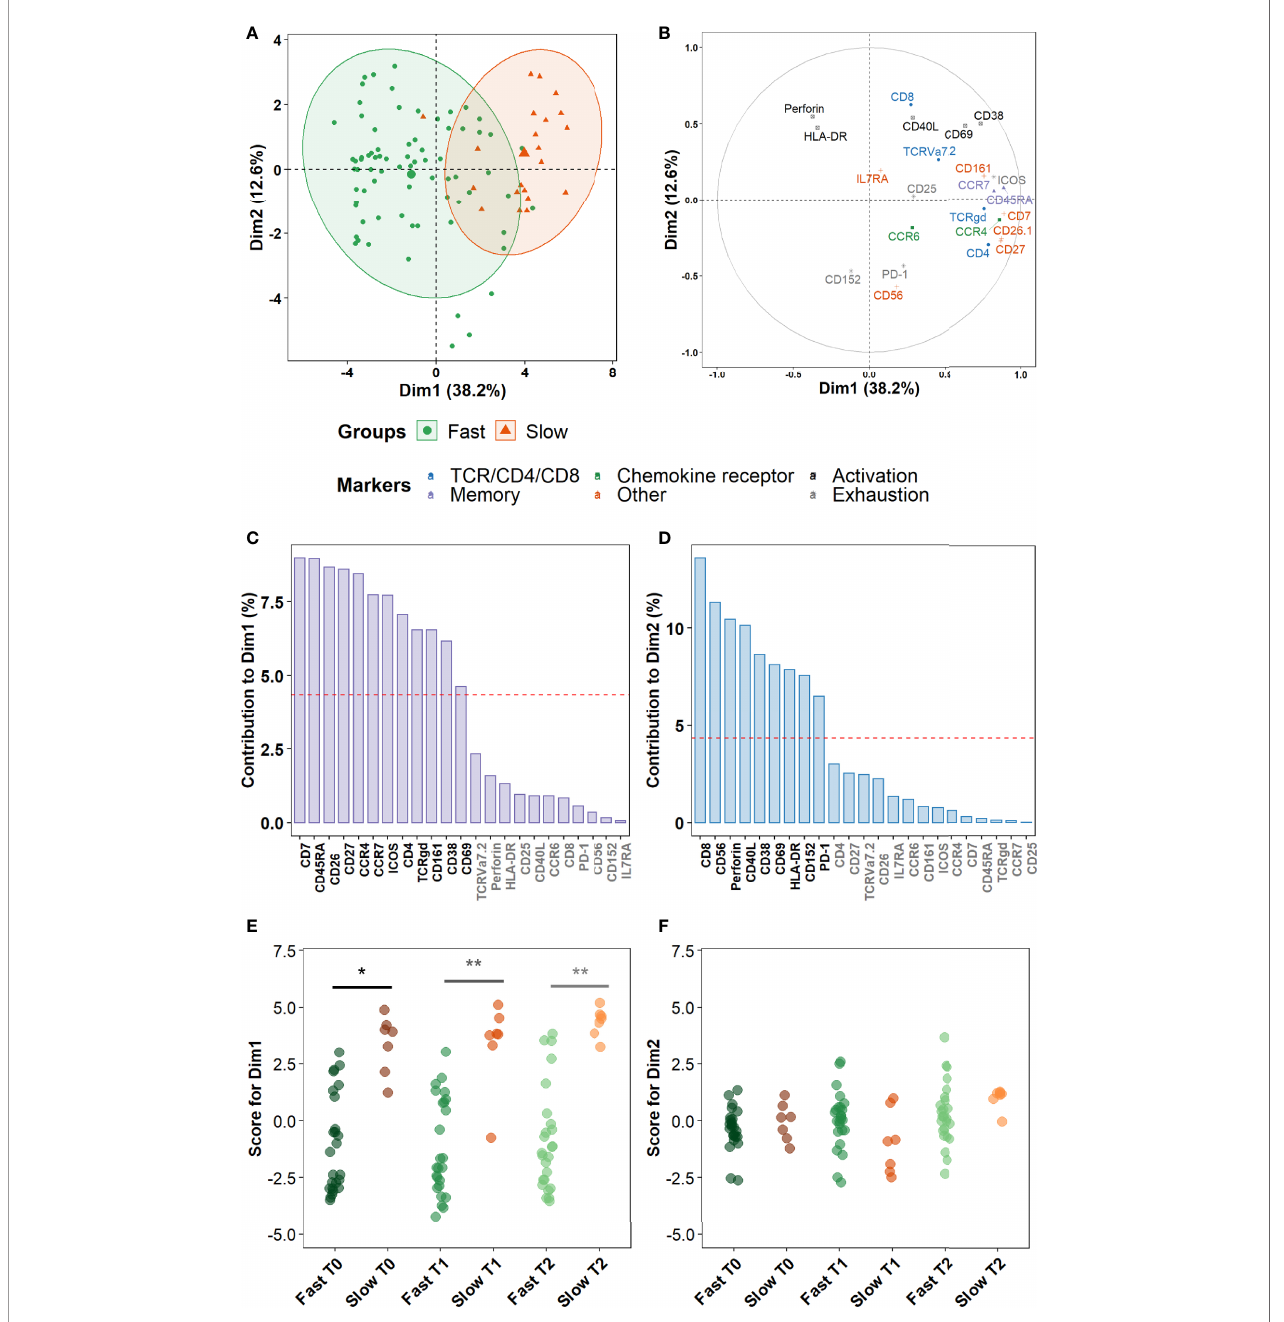
FIGURE 7 | Non-lineage markers discriminate slow and fast responders within differentially abundant subsets. Principal Component Analysis (PCA) was performed on marker expression data from the clusters identi fi ed in Figure 6 , within 96 Mtb -stimulated samples matched at T0, T1, and T2 (TB2: 54 samples; rmsHBHA: 42 samples; see Supplementary Table 1 for sample number details). (A) Explanation of the variance between fast converters (25 samples at each timepoint) and slow converters (7 samples at each timepoint). Axes represent the principal components 1 (Dimension 1, Dim1) and 2 (Dim2). Percentages indicate their contribution to the total observed variance. Axis values represent individual PCA scores. Concentration ellipses correspond to 90% data coverage. (B) Contribution of cellular markers to the variance described by Dim1 and Dim2. Axis values represent marker PCA scores. Color codes represent broad marker functions. (C, D) Quanti fi cation of (B) for Dim1 (C) and Dim2 (D) . Contributions of each marker are expressed as a percentage of the dimensions. The dashed line corresponds to the expected reference value if each marker contributed uniformly to the variance. Markers indicated in gray are below this reference value. (E, F) Distribution of individual PCA score values according to the culture conversion group at each timepoint, for Dim1 (E) and Dim2 (F) . Wilcoxon Rank Sum Test. *p < 0.05. **p < 0.001. Exact p-values and test statistics are in Supplementary Table 9